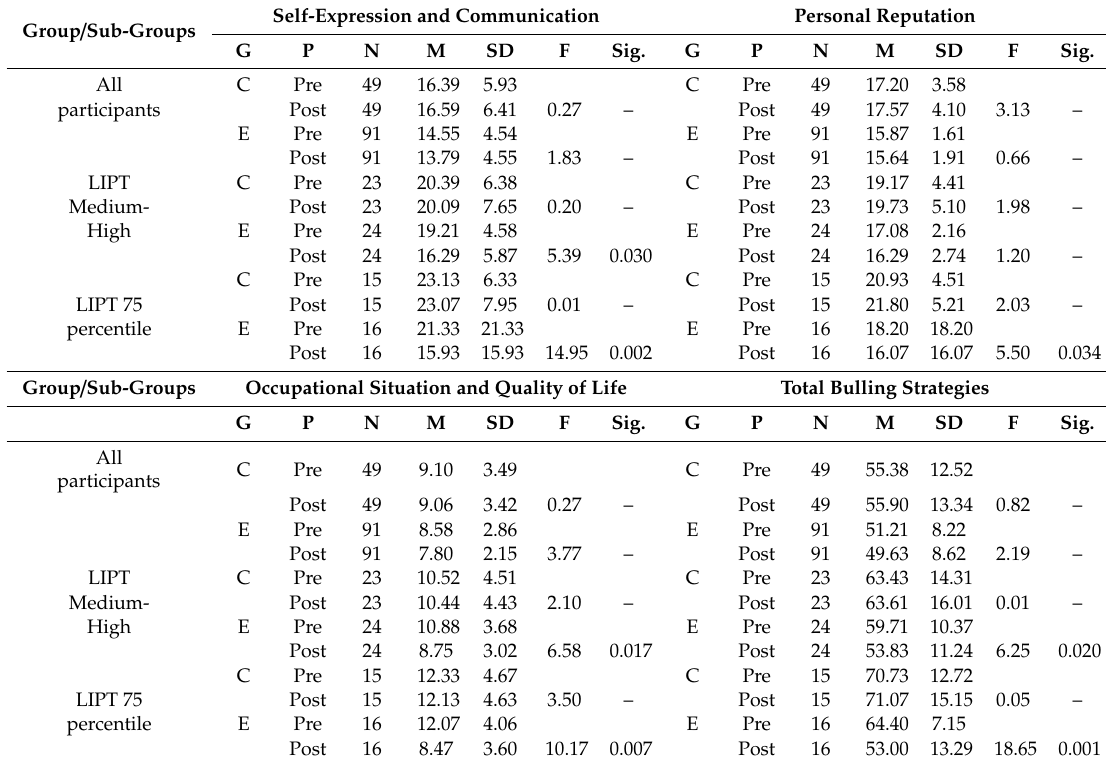
Table 2. Repeated measures analysis. Bullying strategies before and after the intervention for control and experimental group.